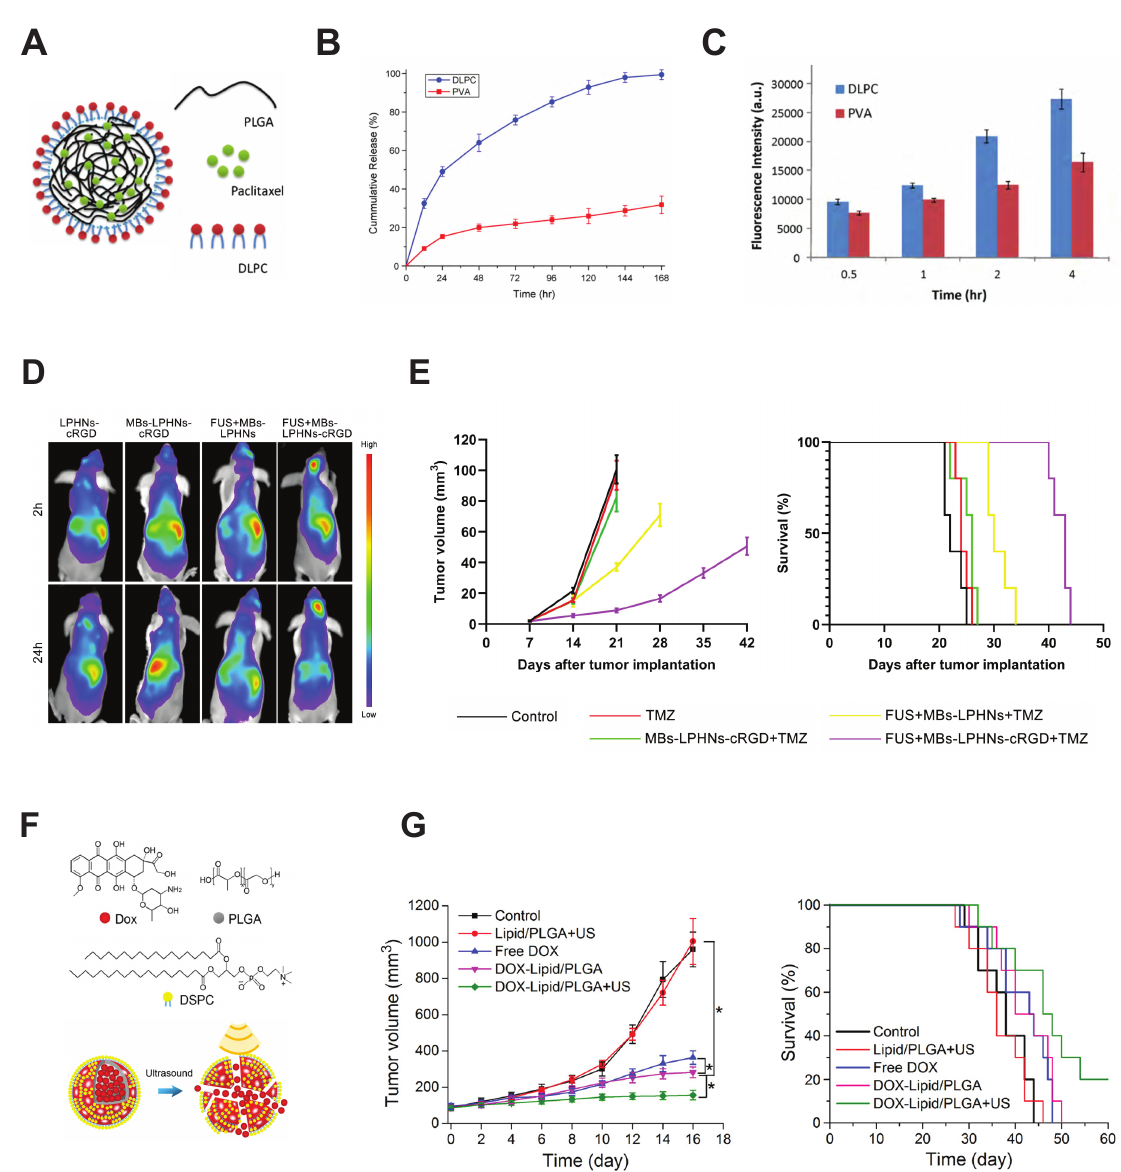
Figure 4. Lipid–polymer hybrid nanoparticles (LPHNs) demonstrate advantages in stability and cargo delivery, and are promising nanocarriers for ultrasound-mediated delivery. ( A ) LPHN com- posed of a polymer core which houses cargo and a lipid outer layer. ( B ) Cargo release magnitude over time was greater from the LPHNs (DLPC, blue) than from polymer nanoparticles (PVA, red). ( C ) Cargo uptake by cells was greater over time when delivered by LPHNs (DLPC, blue) compared to polymer carriers (PVA, red). ( A – C ) reprinted from [133], copyright 2010, with permission from Elsevier. ( D ) Adding ultrasound-responsiveness to LPHNs via microbubble conjugation improved biodistribution and targeting in vivo and enhanced cargo accumulation at the target location in the brain (FUS + MBs-LPHNs-cRGD). ( E ) Using this complex design for the delivery of temozolomide was correlated with inhibition of tumor growth and extended survival (purple). ( D , E ) reprinted from [183]: International Journal of NanoMedicine 2021:16 185–199’ Originally published by and used with permission from Dove Medical Press Ltd. ( F ) Unique model: a microbubble composed of a lipid–polymer hybrid shell, loaded with DOX. ( G ) Ultrasound-stimulated cargo delivery from this system (DOX-Lipid/PLGA + US, green) also resulted in significantly inhibited tumor growth in vivo and greater survival, * p < 0.05. ( F , G ) Reprinted or adapted with permission from [184]. Copyright 2019 American Chemical